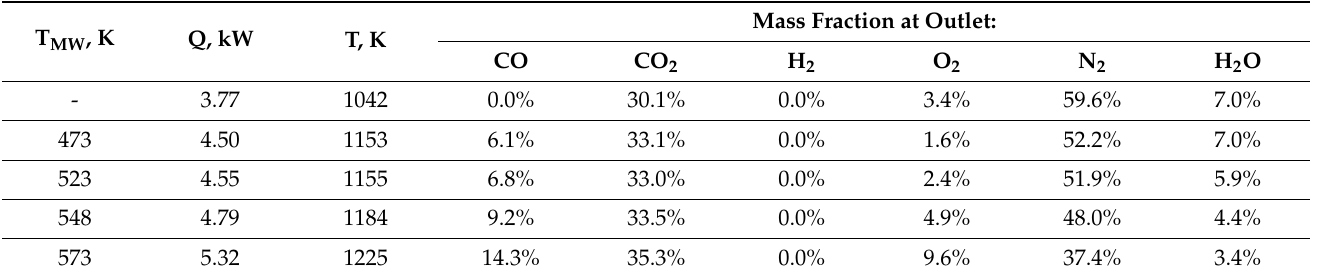
Table 2. Calculated combustion output parameters of straw pellets with different treatment